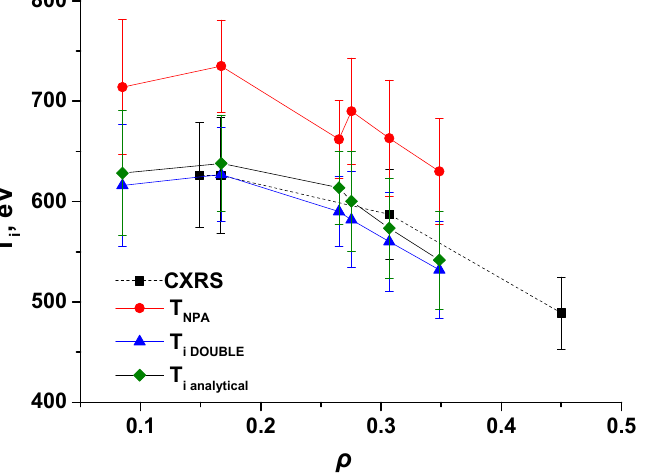
Figure 5. The ion temperature profile in a series of discharges (discharges ##38876,78,79,86,87 with similar parameters) at t = 200 ms. The effective ion temperature profile measured by NPA is shown by circles; the reconstructed ion temperature profiles using the DOUBLE code and semi-analytical Expression (15) are shown by triangles and diamonds, respectively. The CXRS measurement result is shown by black squares. NPA data at ρ = 0.265 are obtained with the ACORD-24M NPA, and data at other points are obtained with the scanning ACORD-12 NPA. The figure is taken from [9] and reproduced with permission from IOP